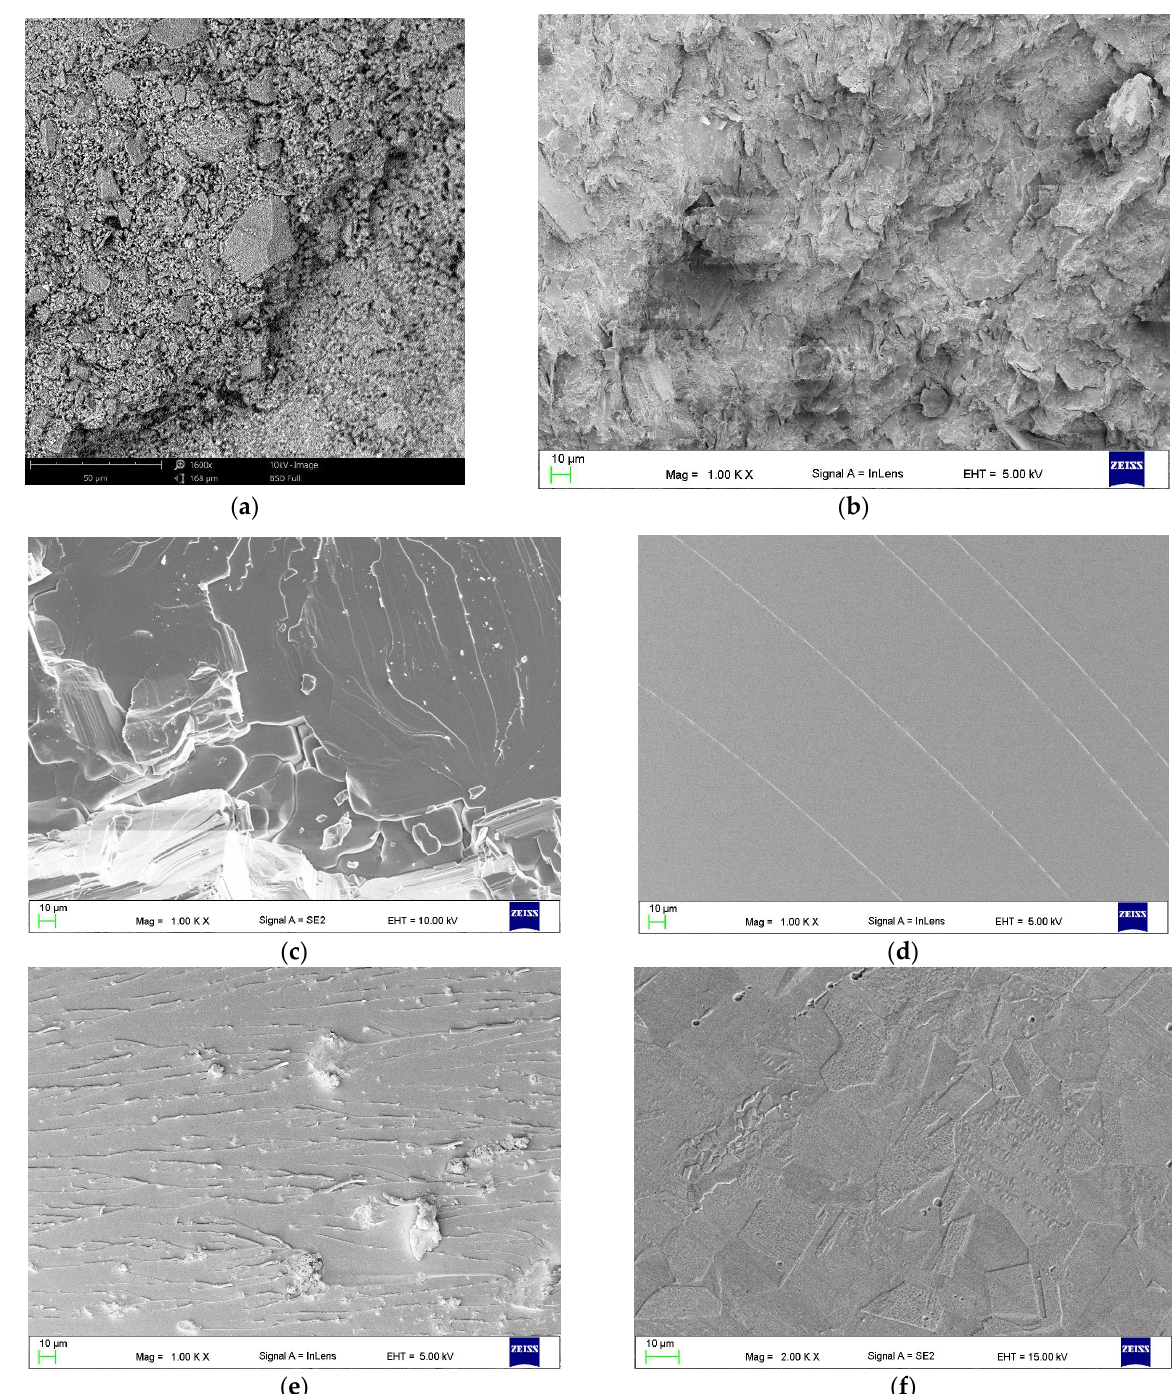
Figure 4. SEM imaging of the surface structure of investigated samples: ( a ) concrete “2” (year 2016); ( b ) mudstone (Carbon); ( c ) salt rock (Permian); ( d ) epoxy resin; ( e ) epoxy resin + graphite (5% vol.); ( f ) stainless-steel.